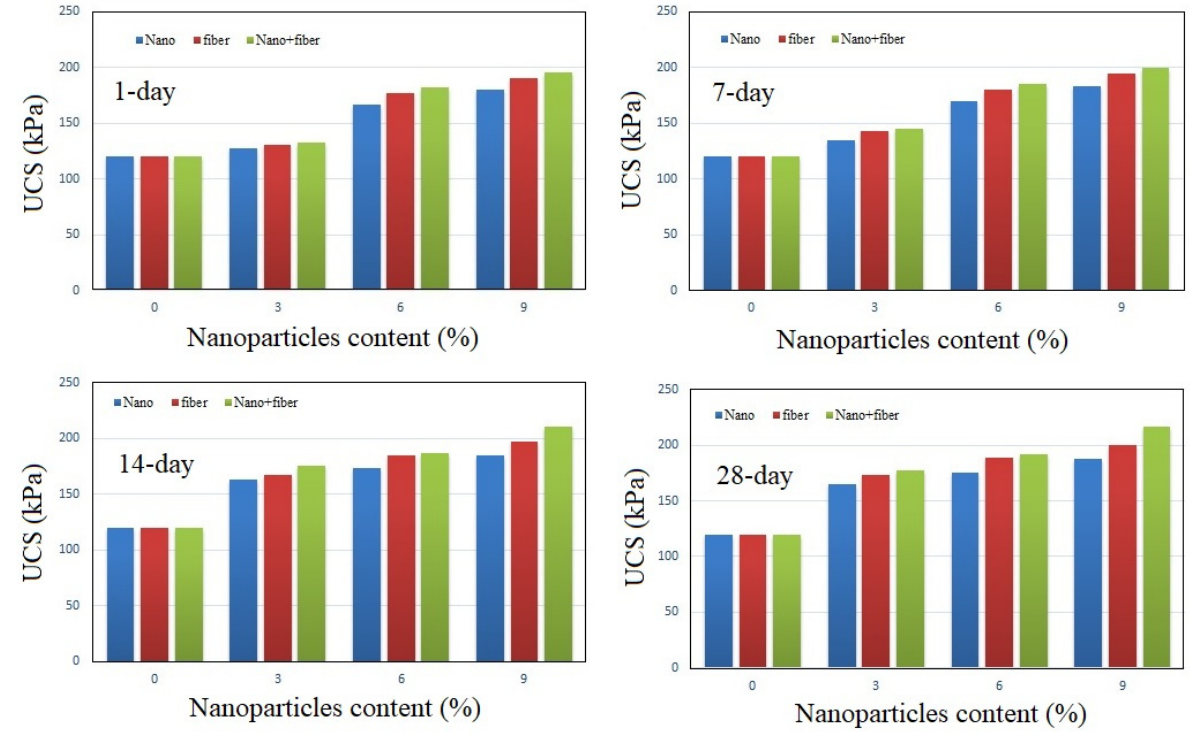
Figure 9. UCS results for a different group of the samples.